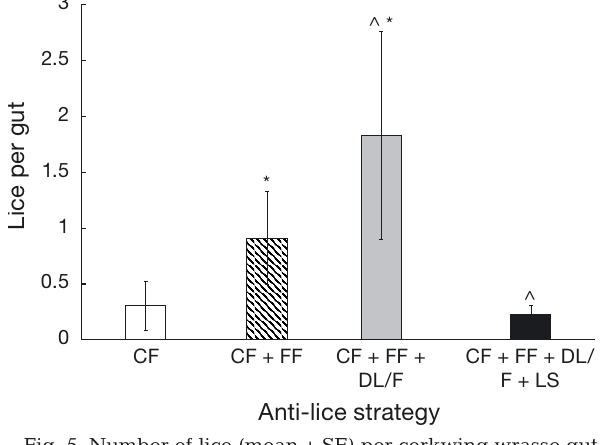
Fig. 5. Number of lice (mean ± SE) per corkwing wrasse gut for each anti-lice strategy. See Fig. 3 for more details